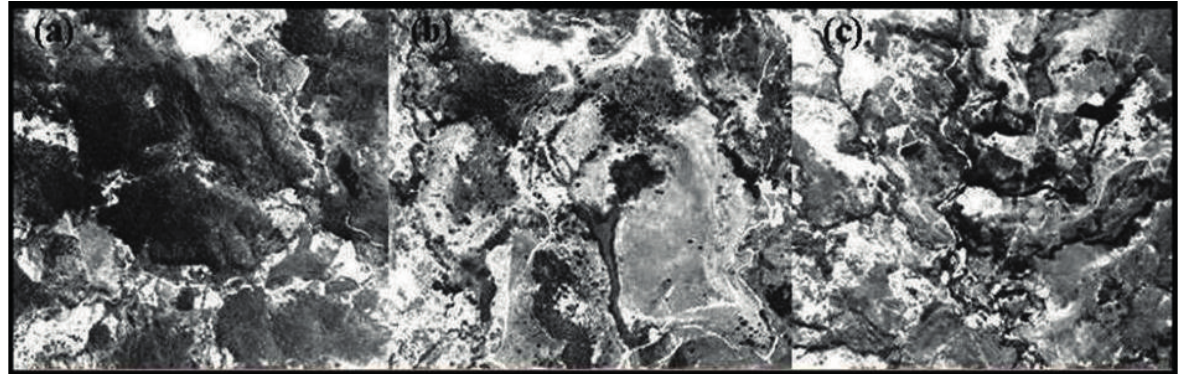
Figure 2 - ( a ) Arboreal (woody, tree) vegetation represented by fine-grained dark color with an irregular appearance; ( b ) Shrubby vegetation represented by fine-grained dark color, but lighter than arboreal vegetation, average saturation, and an irregular appearance; ( c ) Herbaceous vegetation defined by finegrained mid-tone color, low saturation, and an irregular